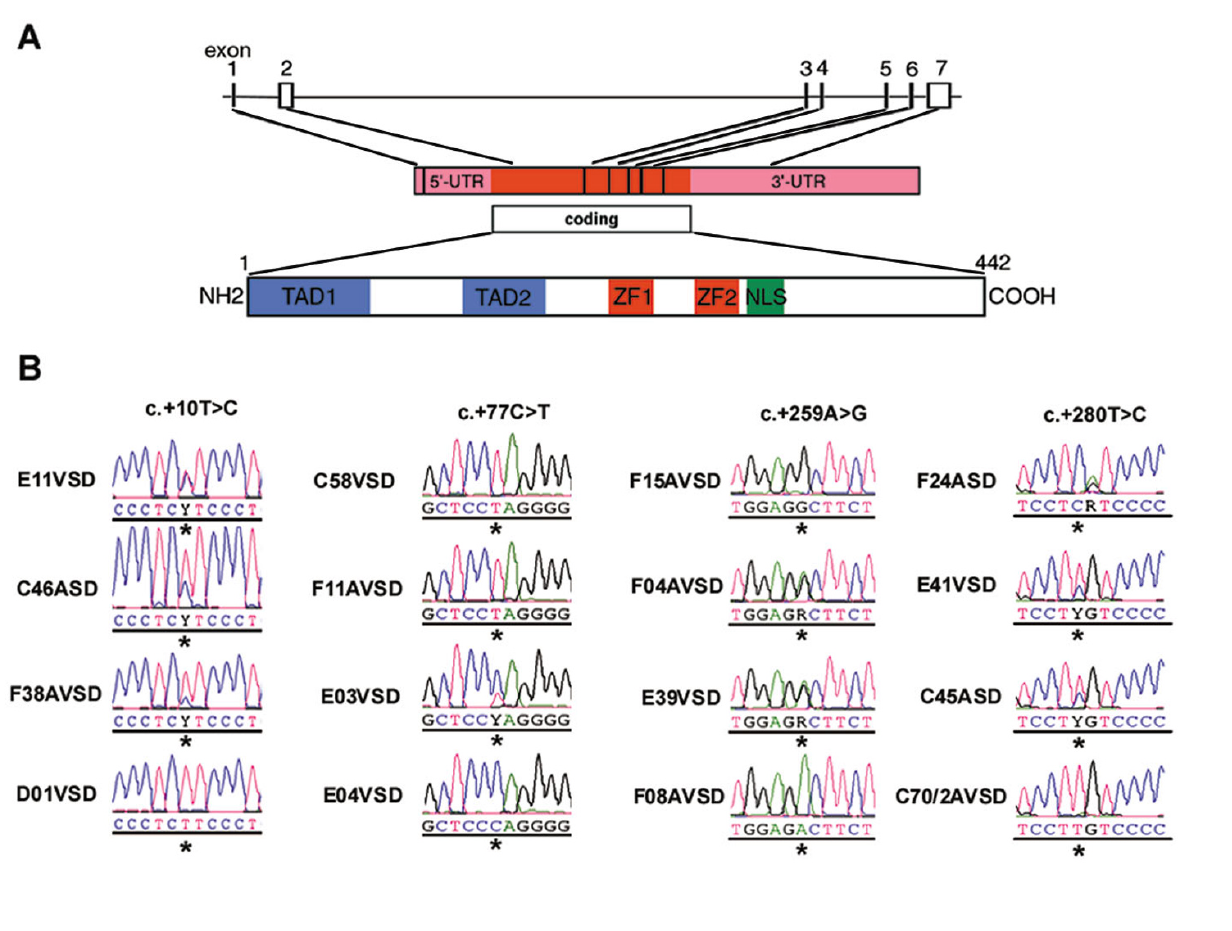
Genetic analysis of GATA4 . (A) Schematic representation of GATA4 (genomic, mRNA and protein level). Reference sequence for GATA4 was based on NM_002052 and the intron-exon boundaries on [42]. (B) Examples of 3'-UTR mutations and geno- types obtained after direct sequencing of fragments amplified from diseased cardiac tissues of patients affected by CHD. Addi- tional sequence alterations in the 3'- UTR of GATA4 were detected, e.g. F24ASD